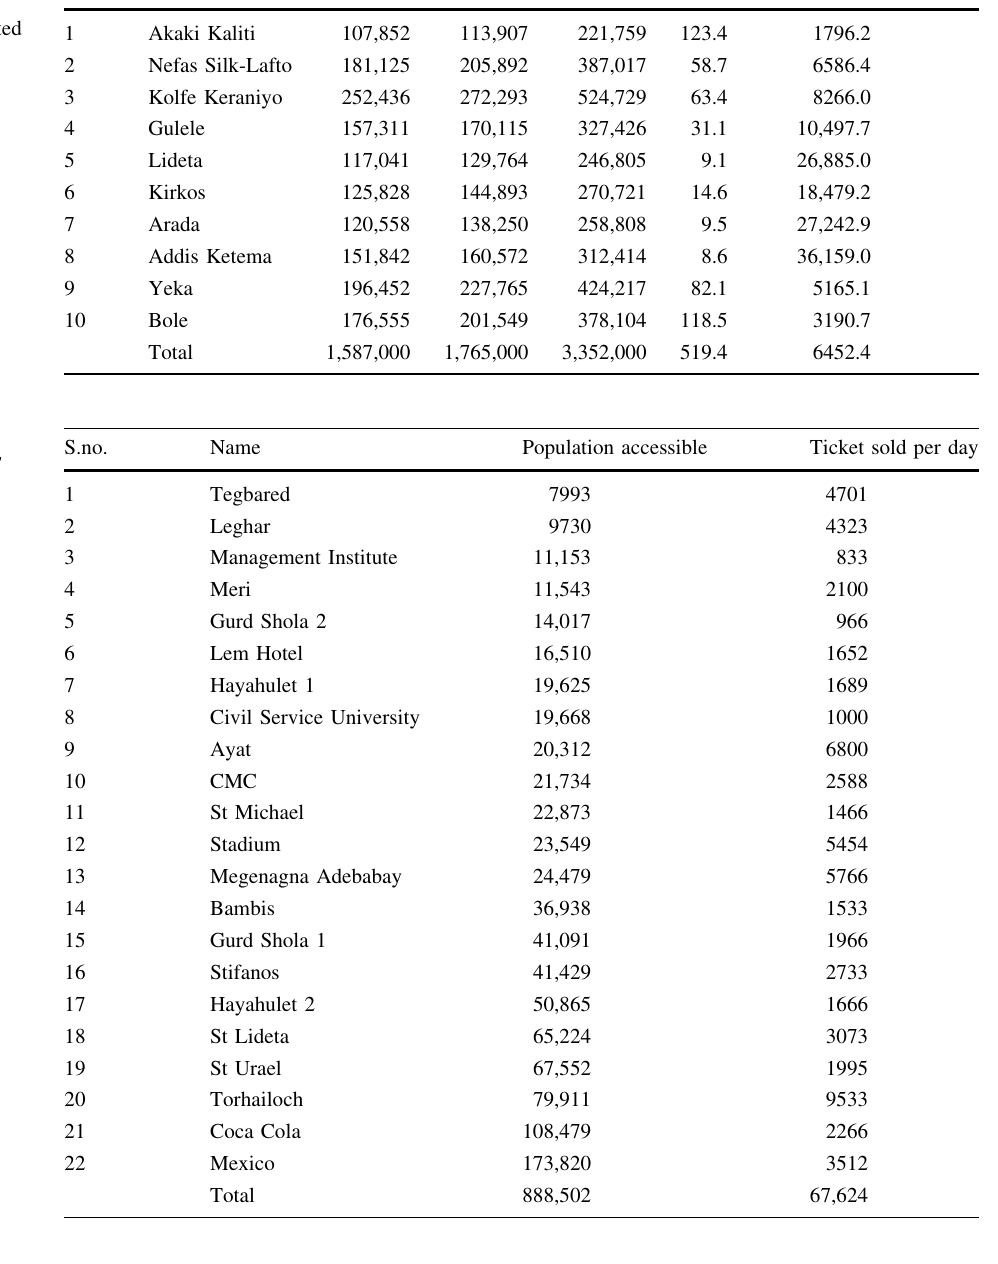
Table 4 Population projection values for the year 2016 and area of sub-cities and computed population density